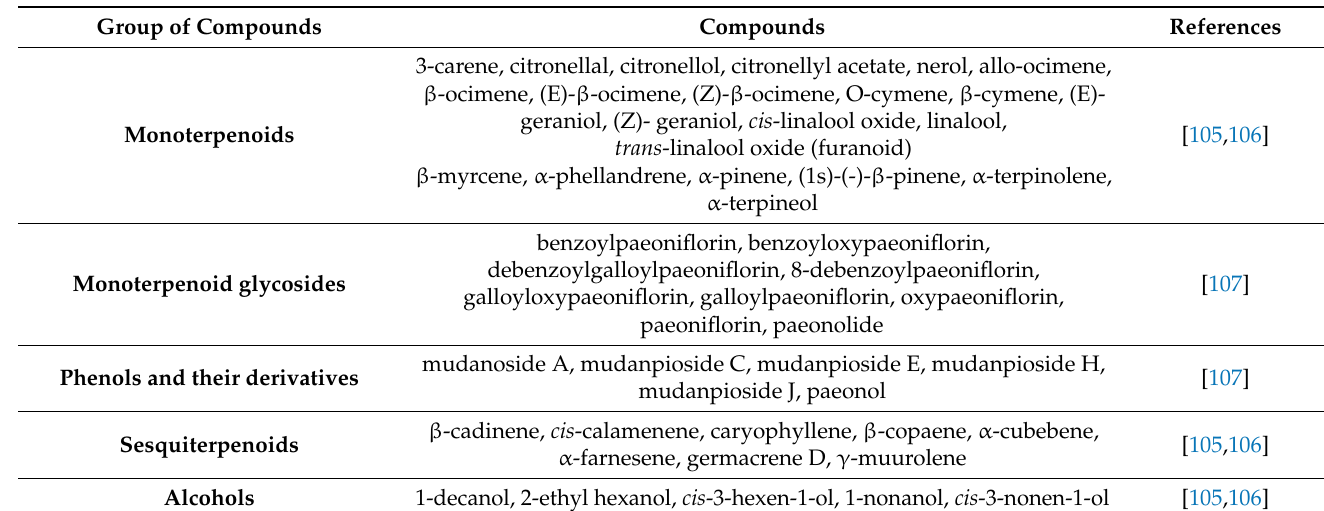
Table 2. The chemical composition of Paeonia × suffruticosa